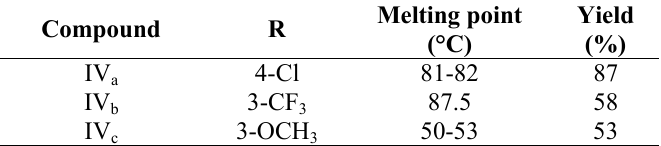
Table 2. Elemental microanalysis of the title compounds.